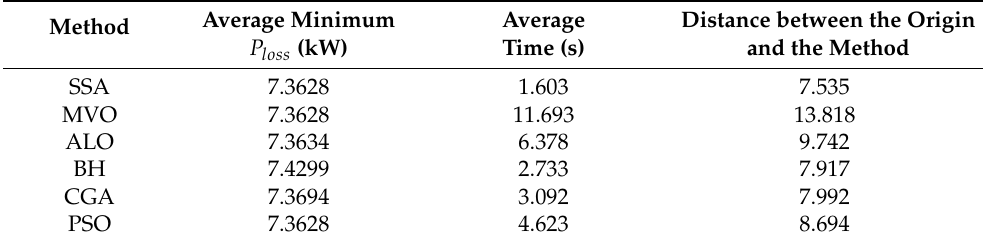
Table 5. Average minimum power losses vs. average processing time in the 21-node system.